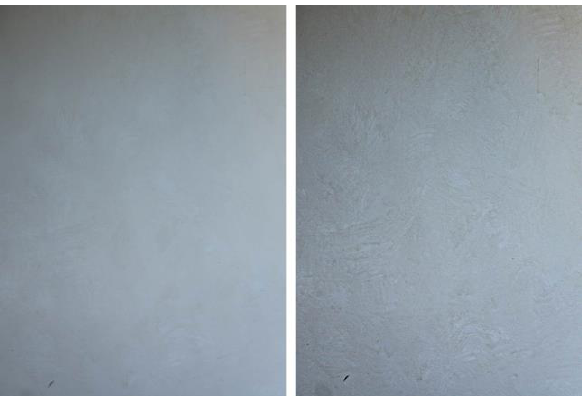
Figure 3. Photo of the plaster of the wall before (left) and after (right) the post-processing on Photoshop This method allowed to align all 88 photos of the south wall.